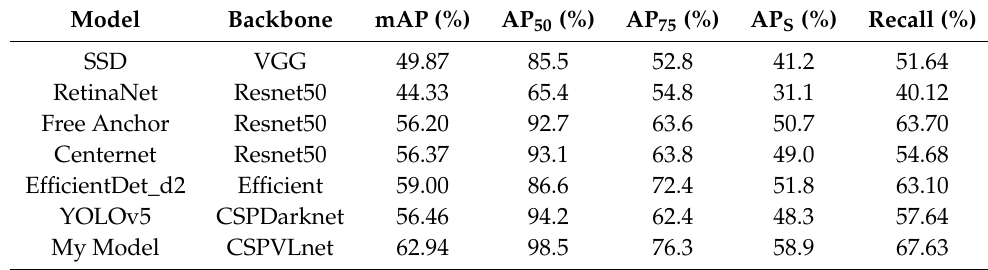
Figure 13. Comparison of detection effect of each detection model: ( a ) example of detection effect of SSD; ( b ) example of detection effect of RetinaNet; ( c ) example of detection effect of Free Anchor; ( d ) example of detection effect of Centernet; ( e ) example of detection effect of EfficientDet_d2; ( f ) example of detection effect of YOLOv5; ( g ) example of detection effect of My Model. Table 3. Comparison results of mainstream detection